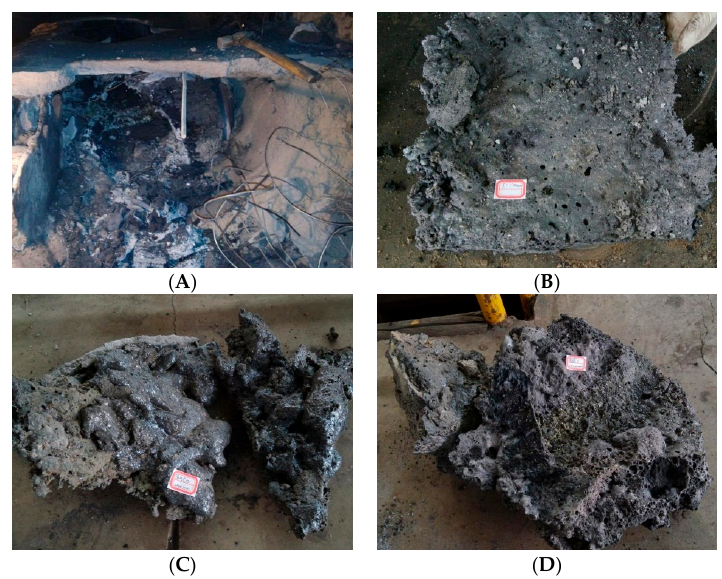
Figure 4. UCG cavity and UCG slag in different atmospheres. ( A ) UCG cavity; ( B ) 40%-O 2 slag; ( C ) 60%-O 2 slag; ( D ) 80%-O 2 slag.